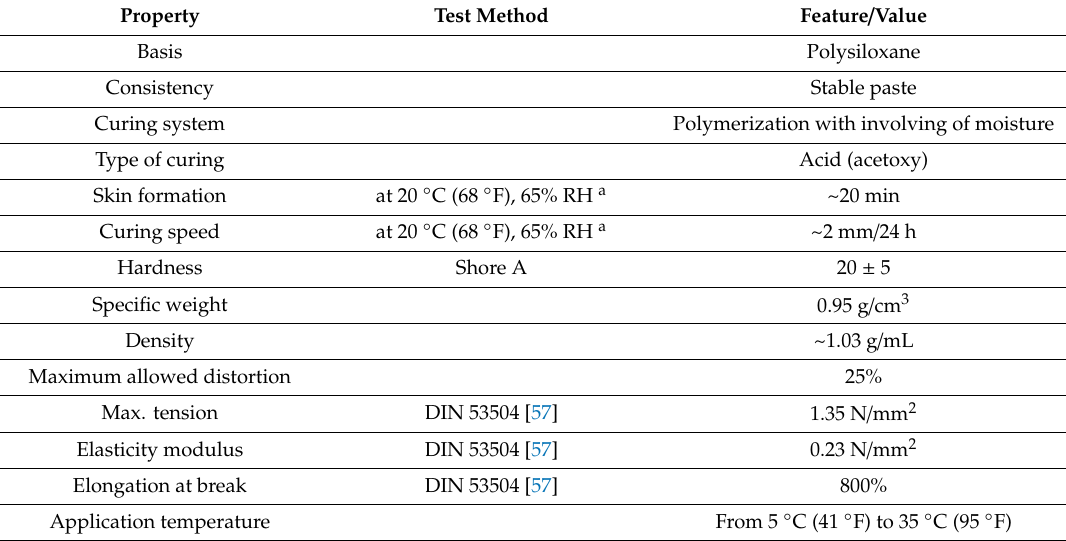
Table 4. General characteristics of universal silicone used during impregnation